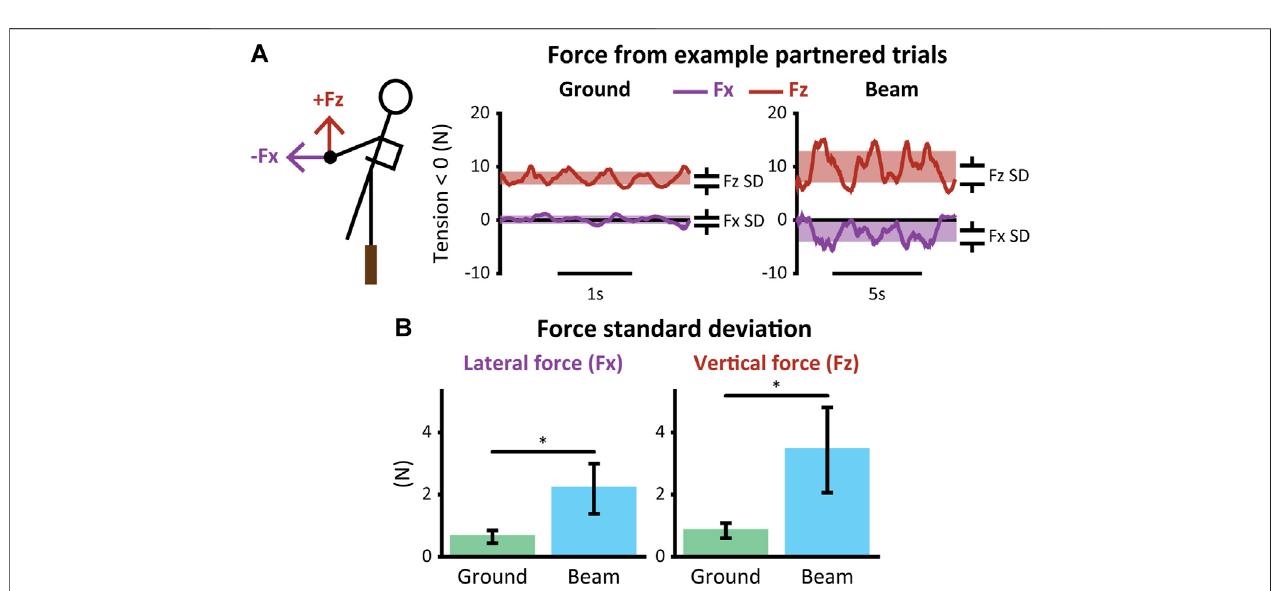
FIGURE 4 | Hand forces during partnered walking. * t -test p < 0.05. Error bars represent ± one standard deviation. (A) Lateral (Fx) and vertical (Fz) hand forces during exampletrials ofoverground(left) and beam (right) walking. Standard deviation wascalculated per trial toquantifymagnitude ofbalanceassistance. (B) Standard deviation of force in each direction during overground and beam walking for all